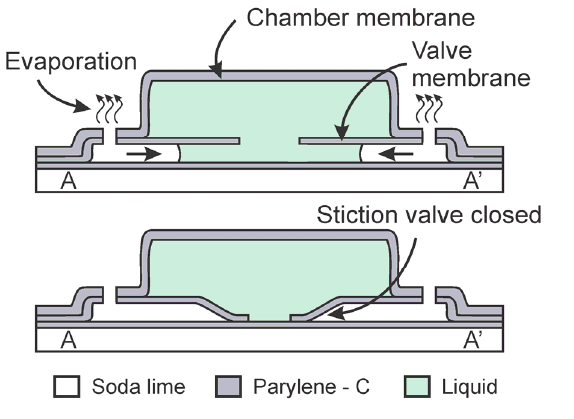
Figure 2. Principle of operation. Evaporation through the fluidic access ports moves the liquid fronts along the connecting channels toward the stiction valve. Capillary forces seal the annular plate of the stiction valve against the substrate trapping liquid inside the chamber ([10]© IEEE